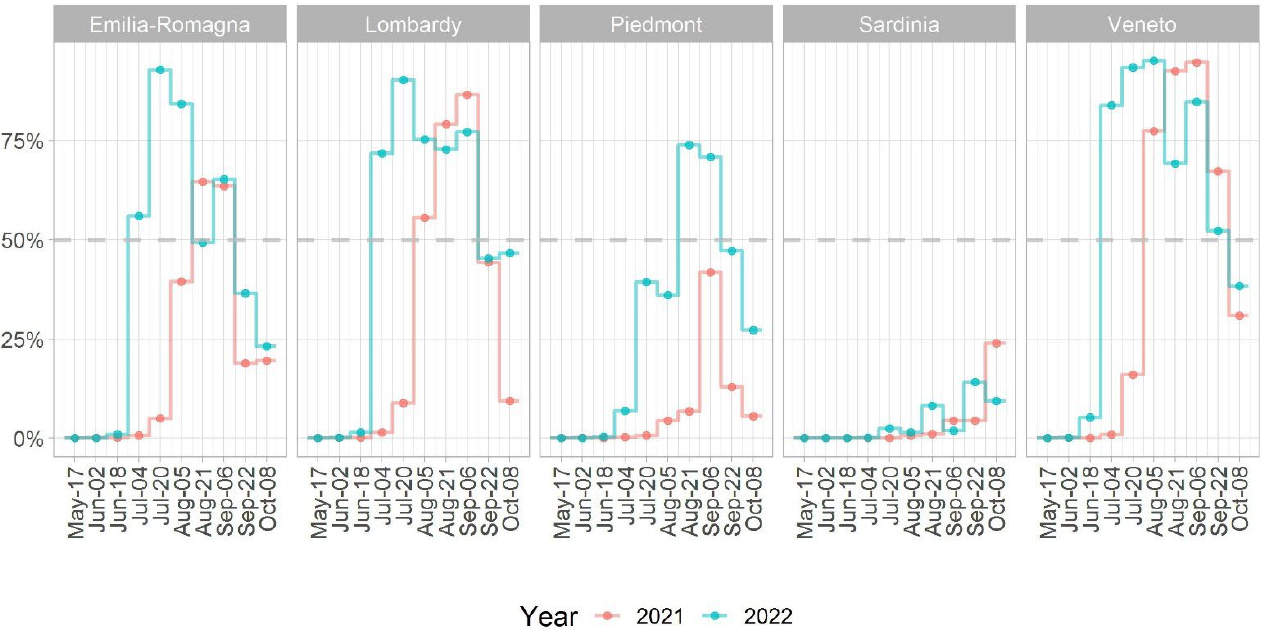
Figure 6. Median values of WNV circulation suitability (probability ranging from 0 to 100%) in five Italian regions during the epidemic season in 2021 (orange line) and 2022 (light blue line). The spatial distribution of the probability across Italy is accessible through the web application https://mapserver.izs.it/gis_wn_predictions/, accessed on 20 October 2022, in which it is possible to view the risk map for WNV throughout the Italian territory with forecast periods of 16 days.